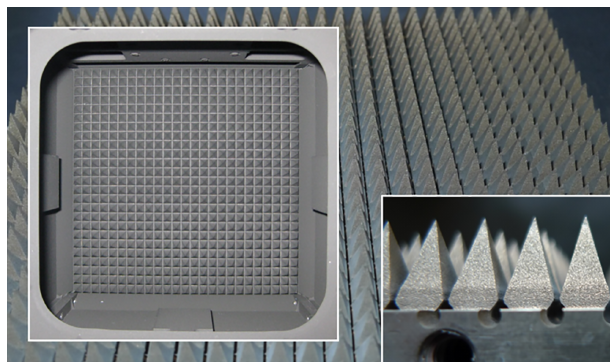
Figure 2. Optical surface of large-area blackbody with wire-eroded pyramid array. Size of a single pyramid: base = 5mm × 5mm; height = 9mm.